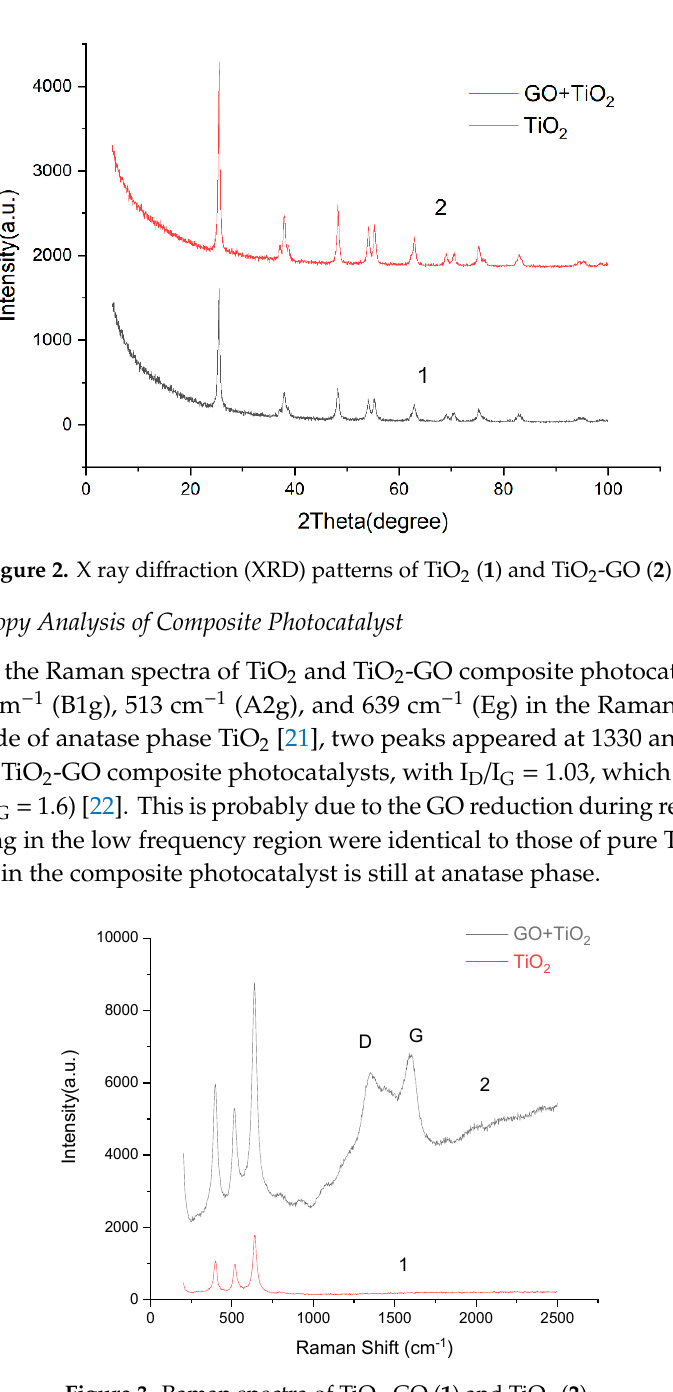
Figure 3. Raman spectra of TiO 2 -GO ( 1 ) and TiO 2 ( 2 ).